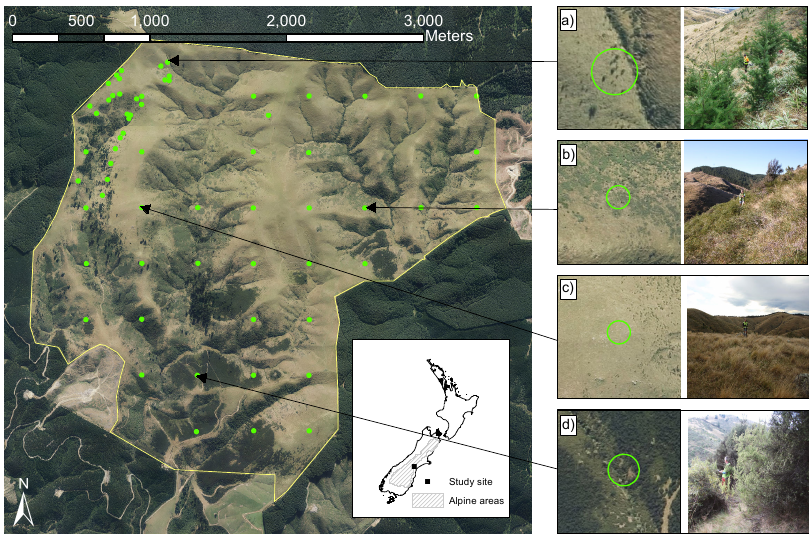
Figure 1. Overview and geographic location of study site and field plots (light green filled circles). Right hand panel shows examples of dominant vegetation types from the study area. These included: ( a ) invasive conifers; ( b ) areas dominated by bracken; ( c ) grassland areas; and ( d ) areas dominated by manuka trees up to 4